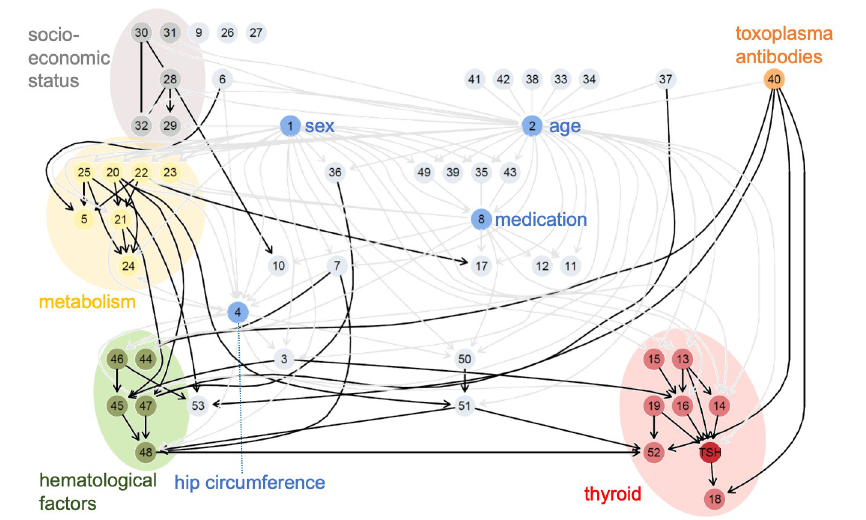
Fig 2. Inferred Bayesian network structure among the extracted relevant predictors and the TSH level. The four hub nodes, sex, age, medication (taken during the last seven days), and hip circumference are colored in blue. Arcs originating from the hub nodes are plotted in light gray to make the network more readable. The TSH level is colored in dark red, thyroid-related examinations in red. Yellow nodes refer to metabolic factors, green nodes to hematological and hemostasis factors, and grey nodes to socioeconomic parameters. Antibody titer against toxoplasmosis is presented in orange. Further information on the features can be found in S1 Table. The completed partially directed acyclic graph is